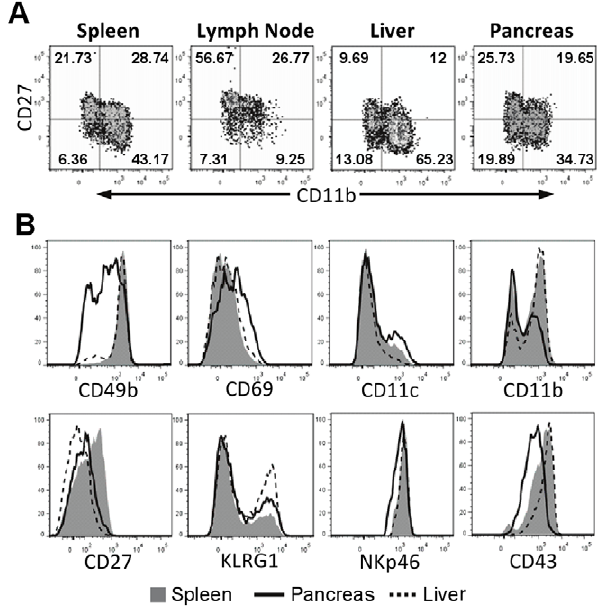
Figure 3. Pancreatic NK cells have an activated phenotype. A) NK cells pooled from five 8-week-old NOD mice were assayed for maturational status using CD11b and CD27. Both the pancreas and liver had more CD11b lo CD27 lo NK cells than in the spleen. B) Histograms of CD11b and CD27 (gated on CD3-, NKp46 + cells) demonstrate a lower mean fluorescence intensity of these markers on pancreatic NK cells relative to splenic NK cells. CD11c, CD69, and KLRG1 were increased on pancreatic NK cells. Lower expression of CD49b, CD43, and NKp46 on pancreatic NK cells was also indicative of activation. Example from one of five similar experiments is shown. similar in both NK cell-depleted and control IgG2a-treated groups (Figure 7a). Adoptive transfer of purified CD4 + T cell from recent- onset diabetic NOD mice into Rag2 2 / 2 NOD.NK1.1 recipients,